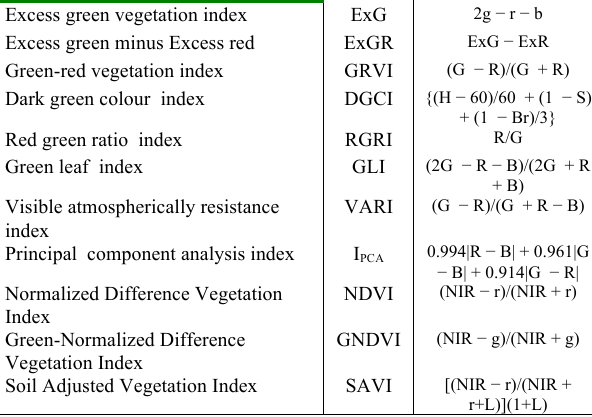
Table 1: Colour indices and vegetation indices